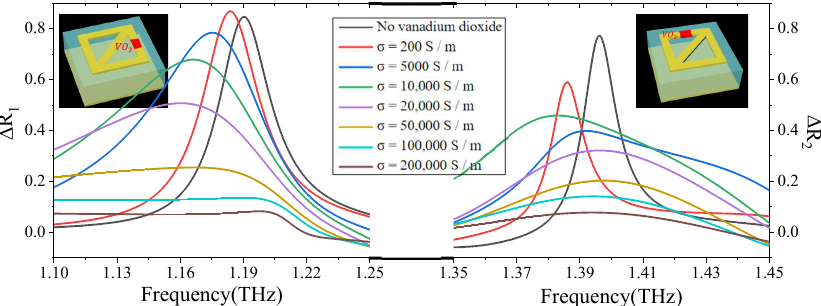
Figure 5. Simulation results of the influence of VO 2 phase change on ΔR 1 and ΔR 2 . The red part of the illustration represents VO 2 . Table 2. Simulation results of the influence of VO 2 phase change on ΔR 1 and ΔR 2.